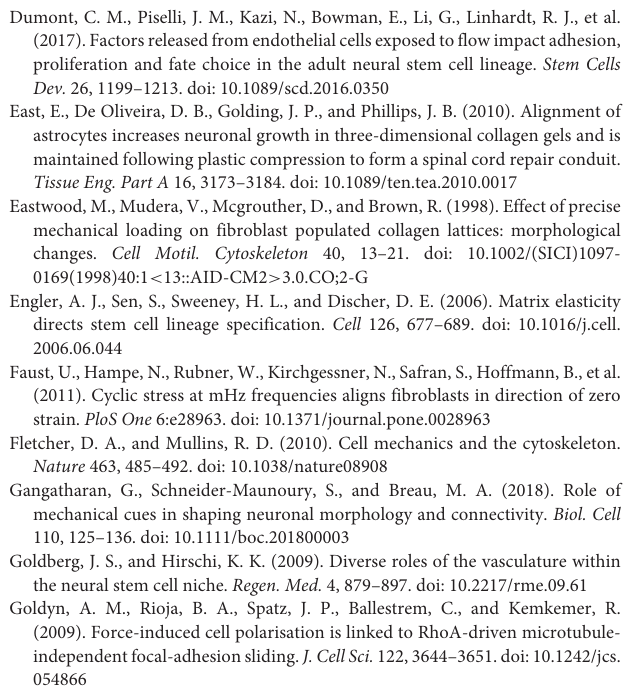
SUPPLEMENTARY FIGURE 1 | Neuronal reorientation in pure and coculture of astrocytes and neuronal cells with RhoA activation. Neurons alone and mixed cultures of neurons and astrocytes (1:1 ratio) were grown and stretched for 24 h in the presence of LPA (30 µ M). Subsequently, cells were stained for actin after fixation and analyzed for main cell orientation. For optimal comparison data from Figure 6 on same cultures in the absence of LPA are indicated as well. For statistical analysis mean distribution angles were compared. ∗ p -value below 0.05 (A) . Same experiments were performed with induction of RhoA for just the last 40 min of cyclic stretching and subsequently compared with the 24 h data shown in A. For those data sets color coding was kept the same (B)